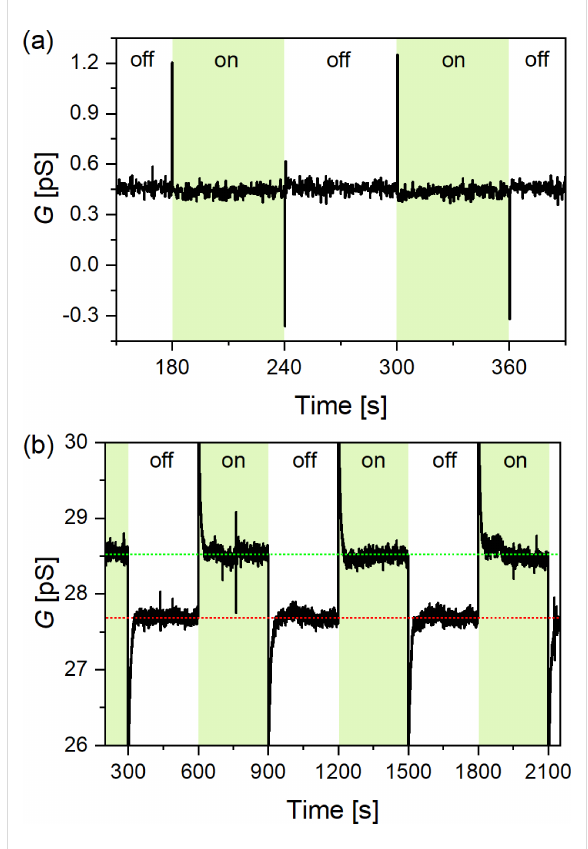
Figure 5: Current vs time traces at 1 V bias. Samples were illumi- nated with a 530 nm light. (a) Ru(TP) 2 -complex wire device. On/off durations of 60 s. (b) Ru(MPTP) 2 –AuNP device, with green and red dotted lines indicating the steady-state conduction values. On/off dura- tions of 300